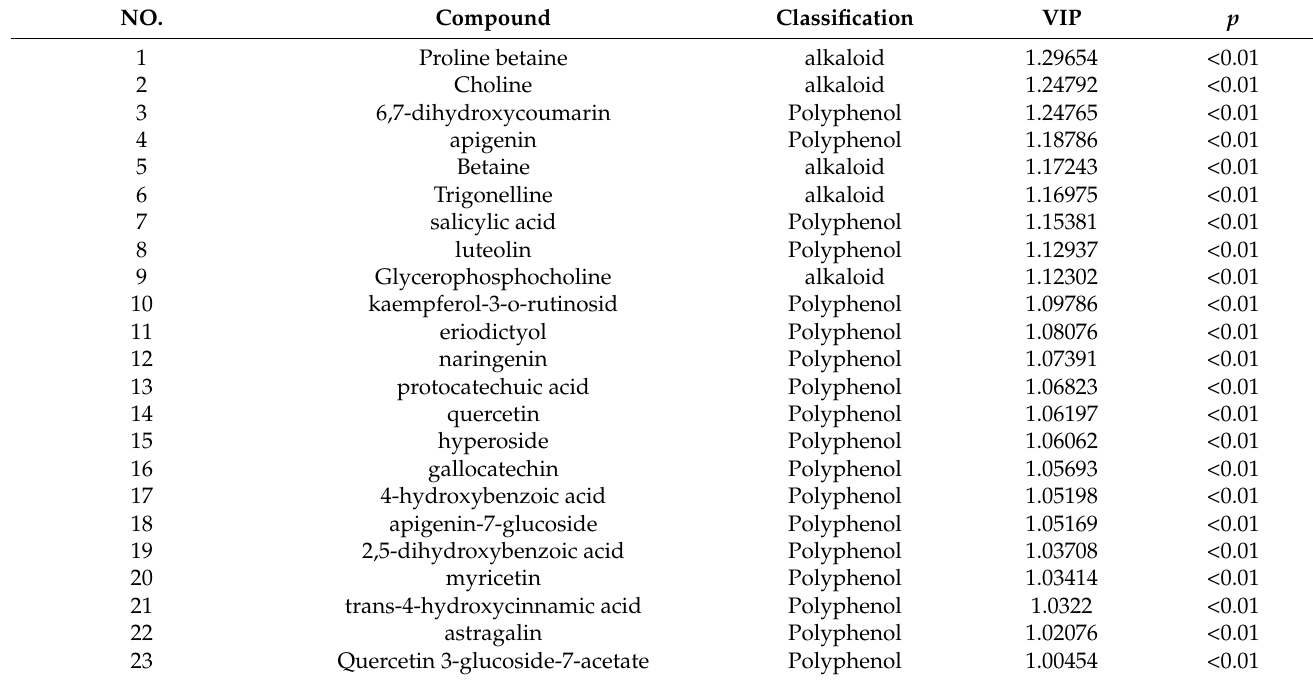
Table 2. Differential metabolites of partridge tea from four origins (SY, WN, WC, and BT) (based on VIP > 1 and p < 0.05).